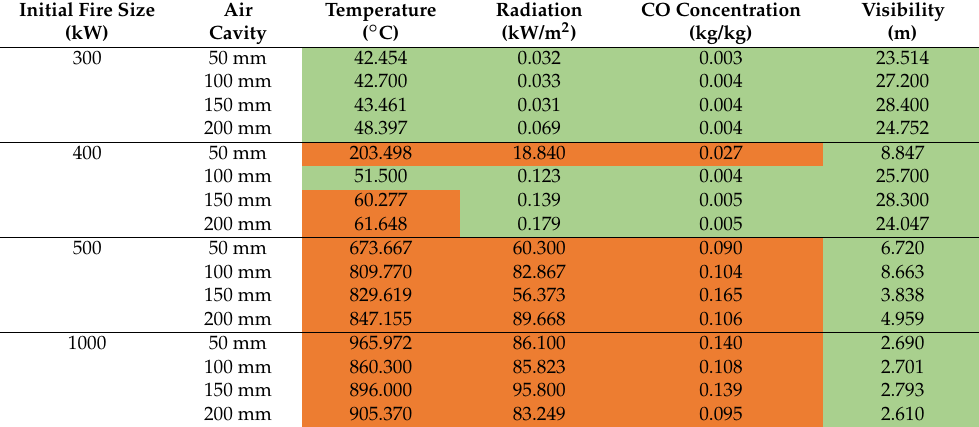
Table 3. Numerical prediction for the tenability parameters at the second floor for cases with variable initial fire size and air gap between insulation layer and external cladding. (parameters above the untenable criteria are highlighted in orange and those below the criteria are highlighted in